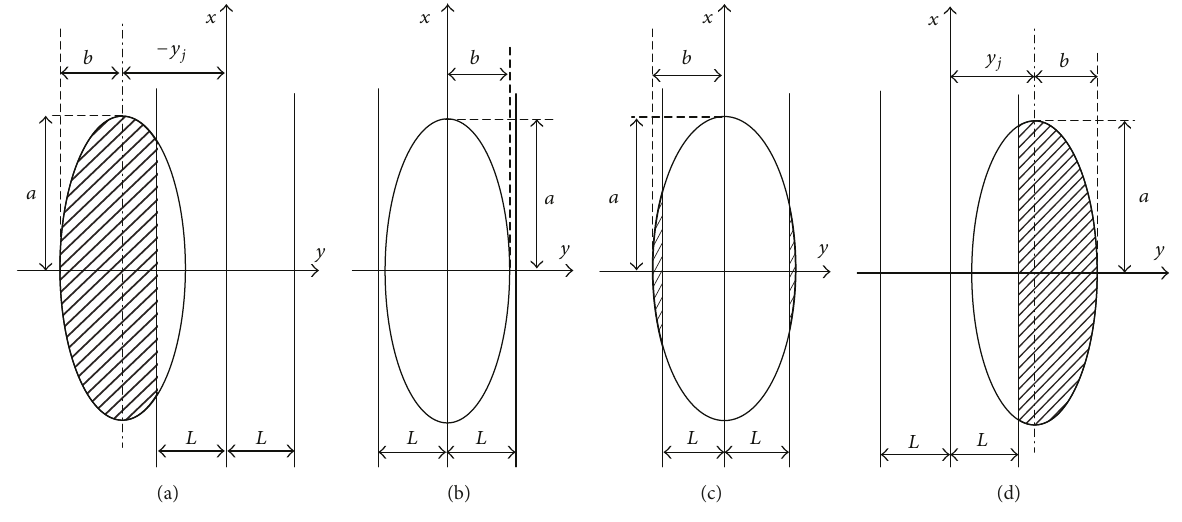
Figure 7: The variation of the ball-raceway contact area at the defect